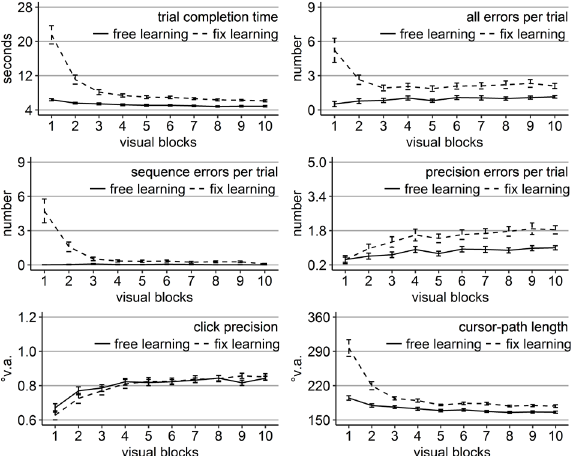
Figure 4. Performance measures during the learning phase of Experiment 2: Trial completion time in seconds, numbers of all errors, sequence errors, and precision errors per trial, click precision in °v.a., and cursor-path length in °v.a. (y-axes) over the course of the ten visual blocks (x-axes) for the two learning groups (free gaze as solid line and fix gaze as dashed line). Error bars represent standard errors of the